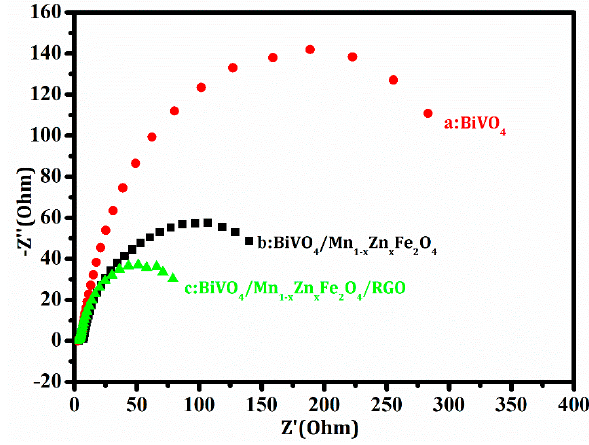
Figure 8. EIS of the work electrode containing BiVO 4 ( a ); BiVO 4 /Mn 1-x Zn x Fe 2 O 4 ( b ) and BiVO 4 /Mn 1- x Zn x Fe 2 O 4 /RGO ( c